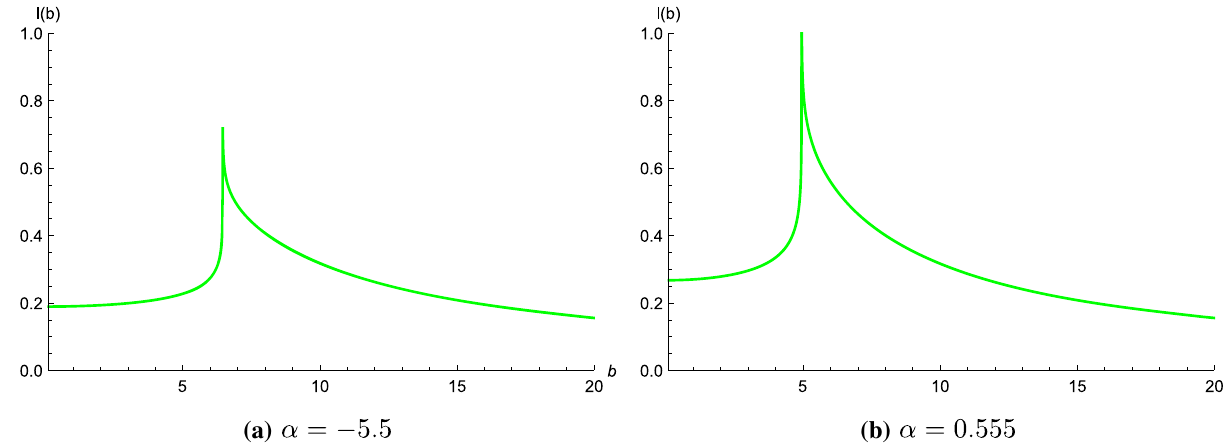
Fig. 3 Profiles of the specific intensity I ( b ) seen by a distant observer for a static spherical accretion. We set M = 1 and take α = − 5 . 5 (left panel), and α = 0 . 555 (right panel) as two